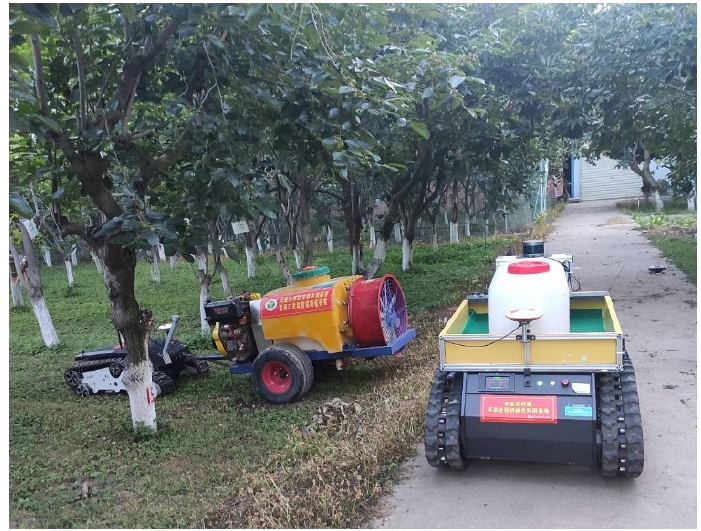
Figure 19. Collaborative navigation trials in orchards.